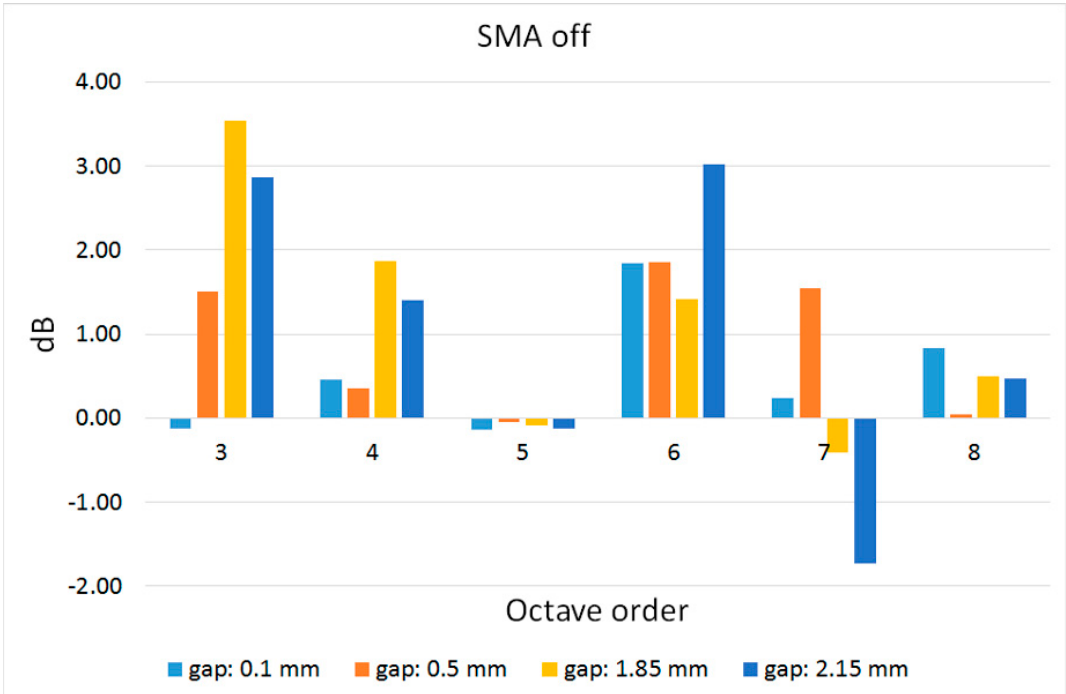
Figure 24. Sound pressure level without activating the SMA system.